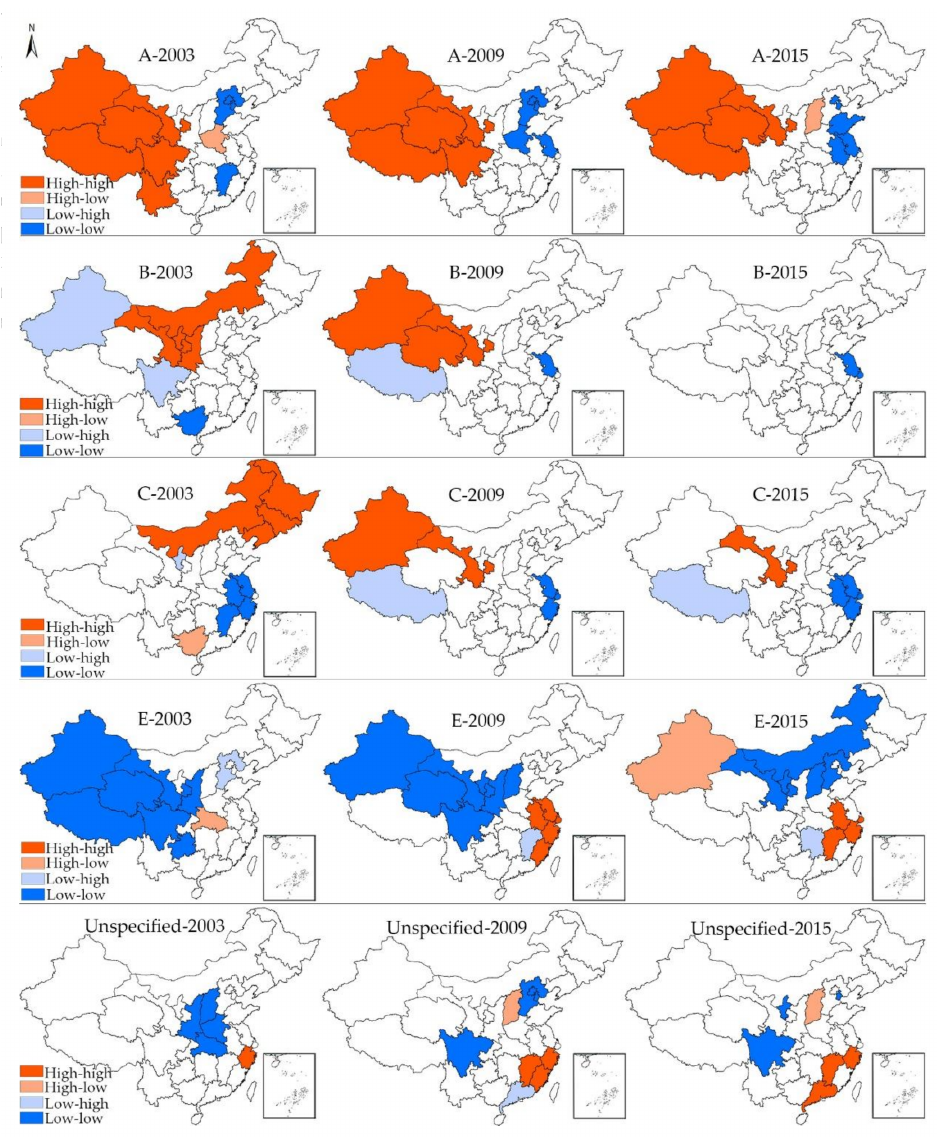
Figure 4. Spatial clusters of all type of viral hepatitis in 2003, 2009,